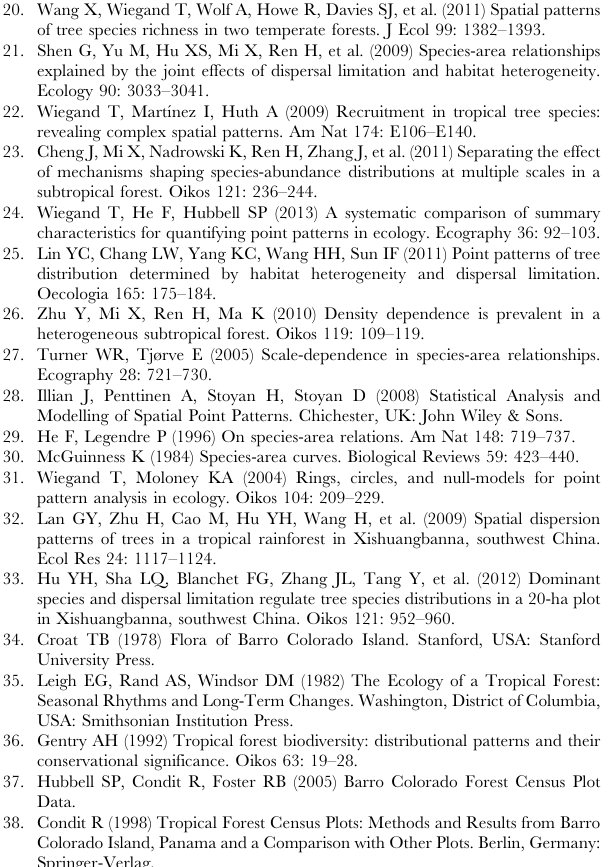
class effect. The units of x and y axes are meter. See Figure 4 for the abbreviations. (TIF) Table S1 The p-values of pairwise Wilcoxon rank sum tests on SAR and g(r) AIC values among the three point process models at DBH class 0 (that is: size-classes 1, 2 and 3 combined). (DOC) Data S1 Dataset for the Bubeng 20